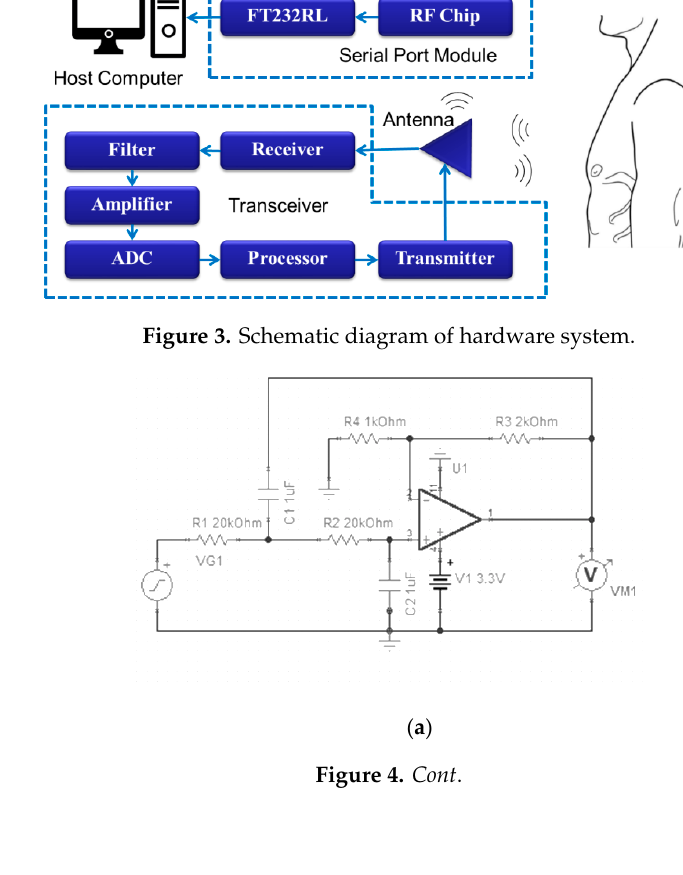
Figure 2. The three-dimensional radiation pattern of the dipole array antenna used in the system.